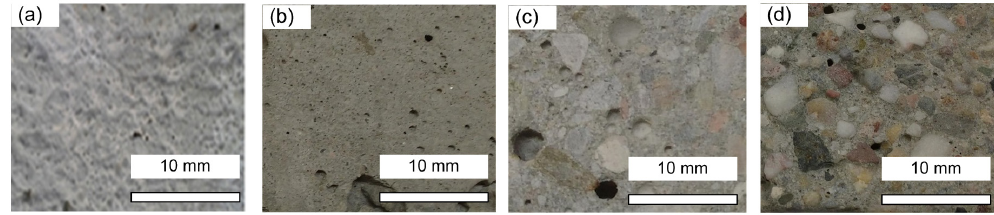
Figure 1. Optical views of the differently treated concrete surfaces: ( a ) raw; ( b ) as cast; ( c ) ground; ( d ) shotblasted.